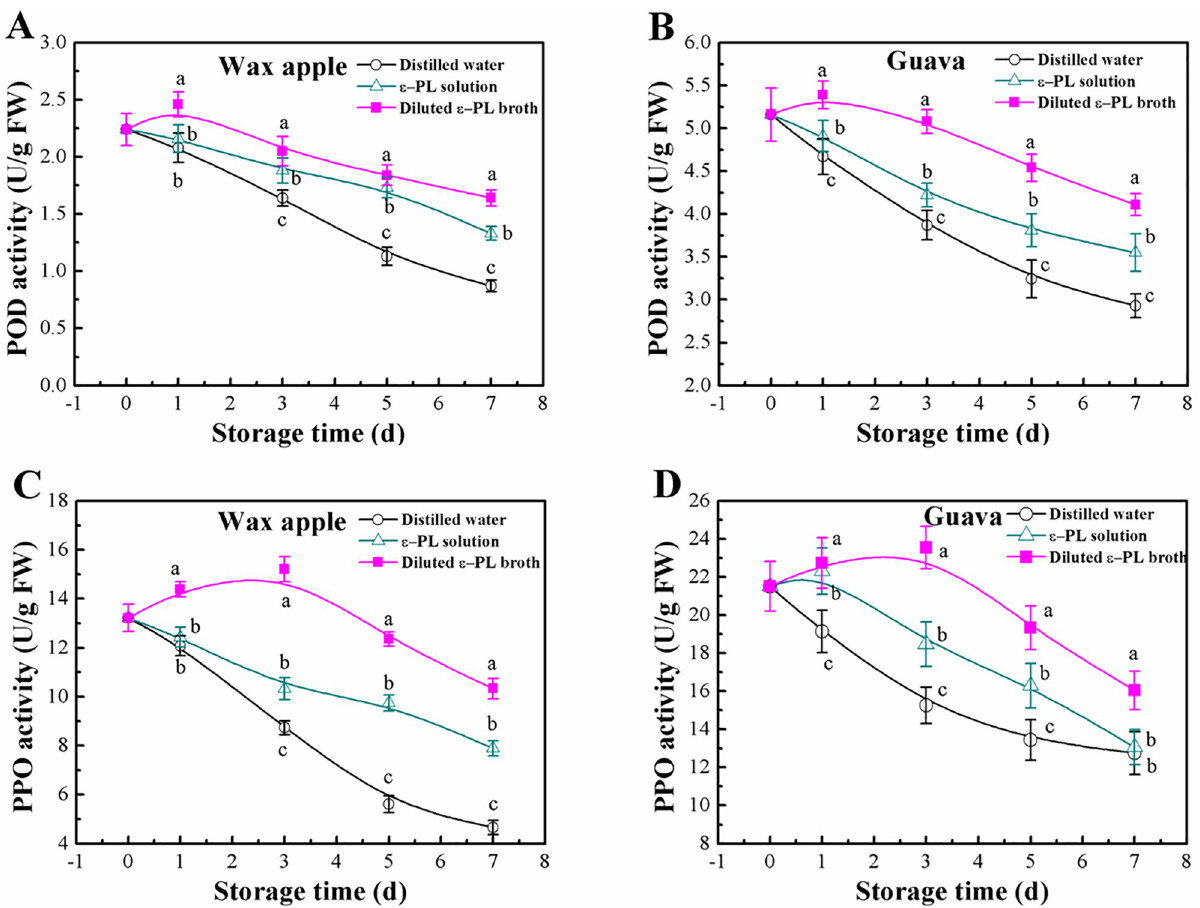
Fig 5. Effects of ε -PL broth on the activity of POD and PPO in wax apple and guava fruits during postharvest storage. ε -PL concentration was 200 mg/L in both solutions. Different letters at the same time point indicate significant differences at P < 0.05. Vertical bars represent standard deviations of the means (n =